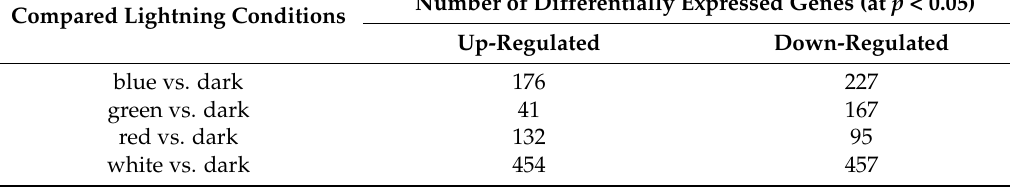
Table 3. Number of C. unicolor genes whose expression differed significantly (at p < 0.05), during fungus growth in the tested lighting conditions in comparison to the control (darkness). Only genes whose transcripts abundance (FPKM) in at least one of the tested conditions was >1 were considered. Number of Differentially Expressed Genes (at p < 0.05) Compared Lightning Conditions Up-Regulated Down-Regulated blue vs. dark 176 227 green vs. dark 41 167 red vs. dark 132 95 white vs. dark 454